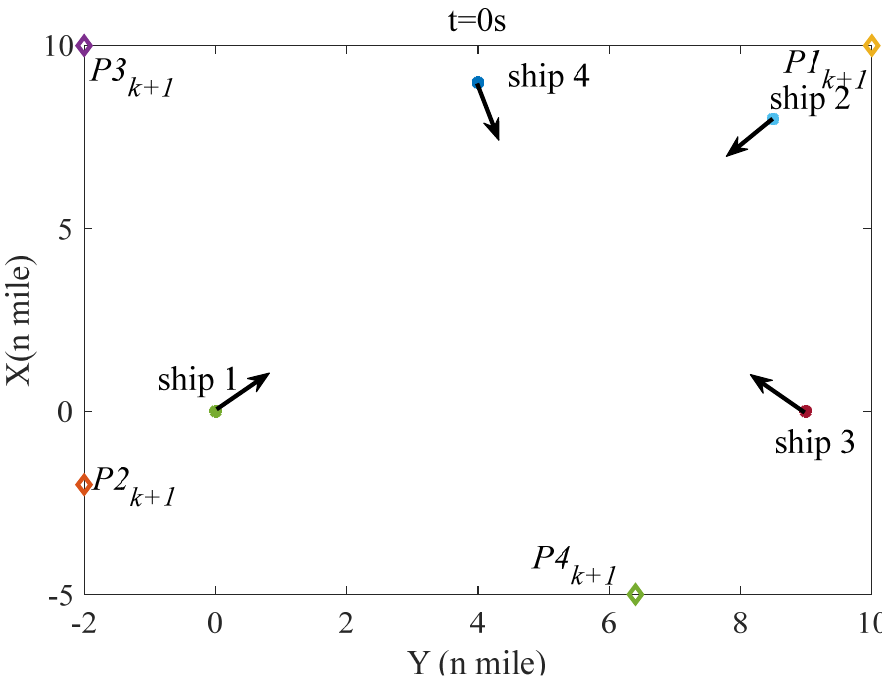
Figure 12. The initial situation of four ships in scenario 2.